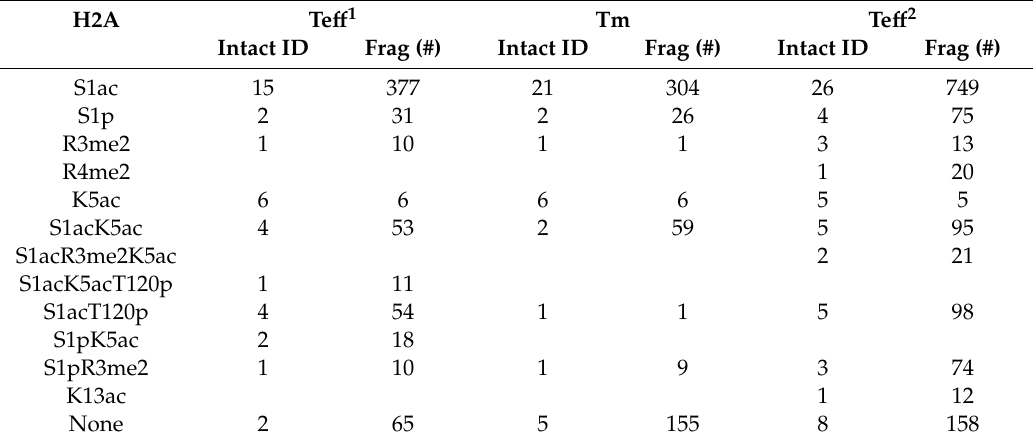
Table 2. H2A modifications from Te ff 1 , Tm, and Te ff 2 after influenza infection. H2A Te ff 1